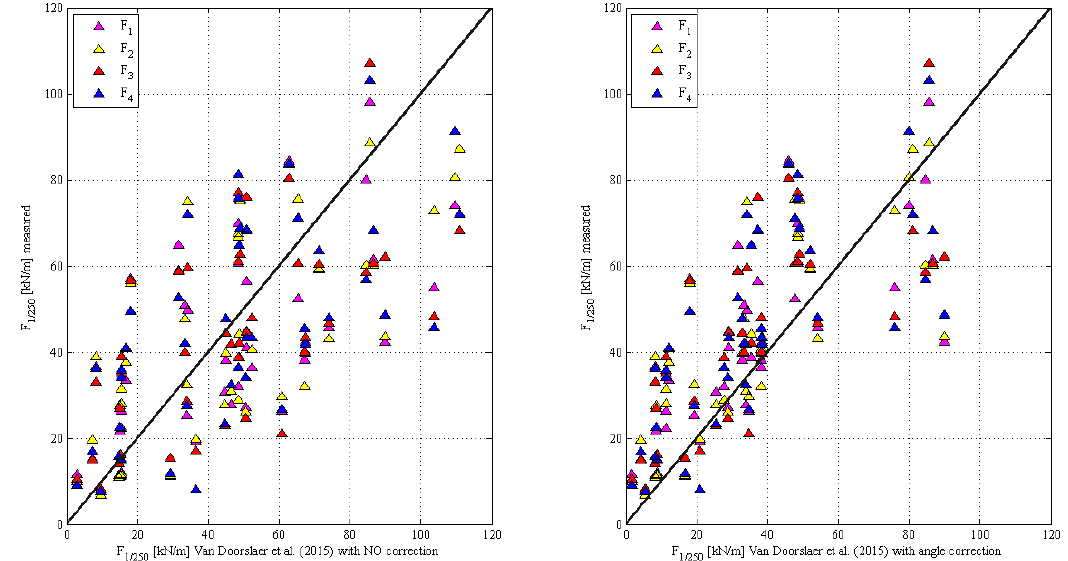
Figure 21. Application of Van Doorslaer et al. [10] formula with and without reduction factor for wave obliqueness.